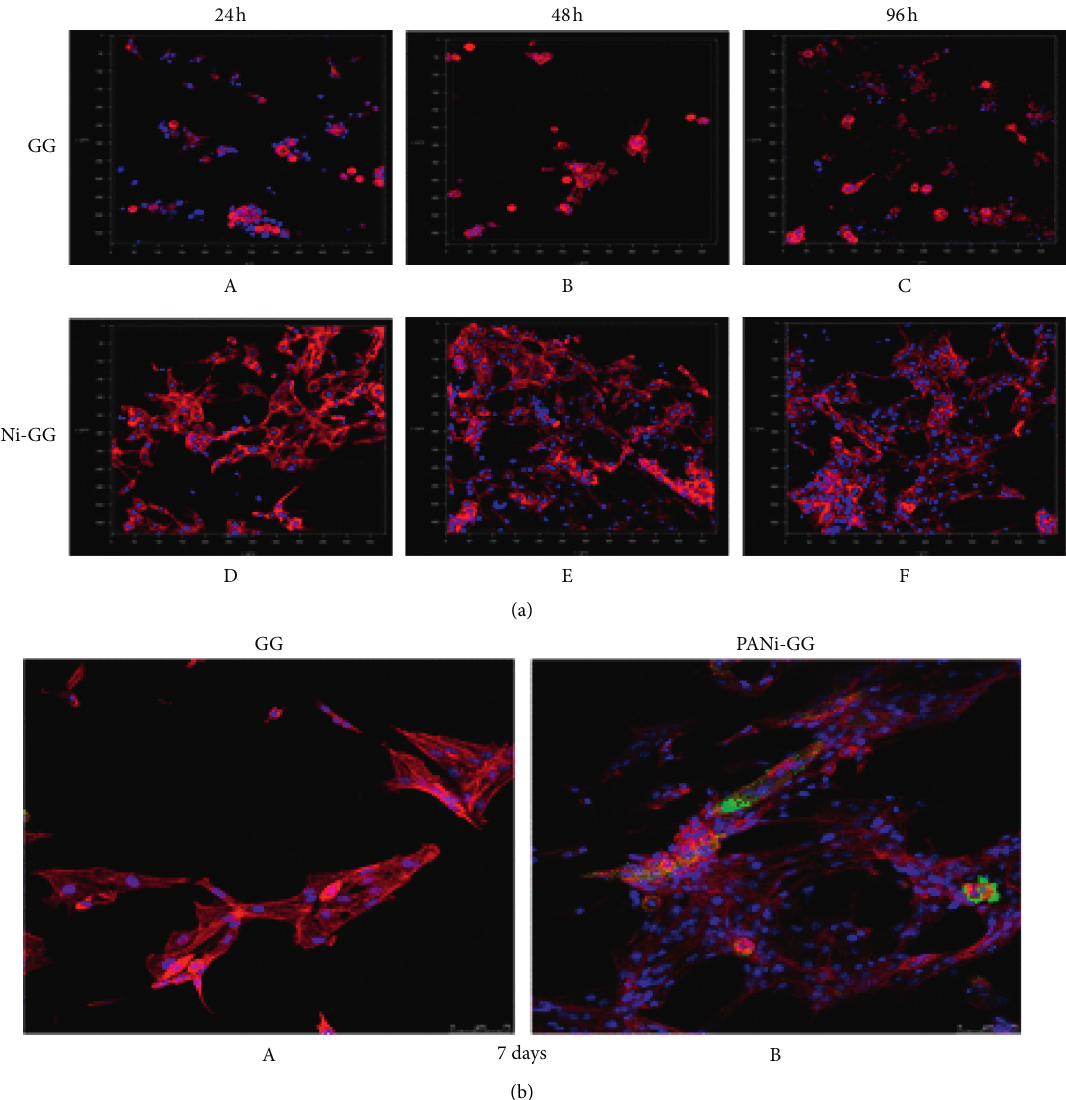
Figure 3: (a) C 2 C 12 cells morphology cultured on GG (A), (B), and (C) and PANi-GG spongy-like hydrogels (D), (E), and (F). (b) C 2 C 12 immunostaining with antimyosin after 7 days of culture on GG (A) and PANi-GG spongy-like hydrogels (B) [77]. Copyright © 2018, American Chemical